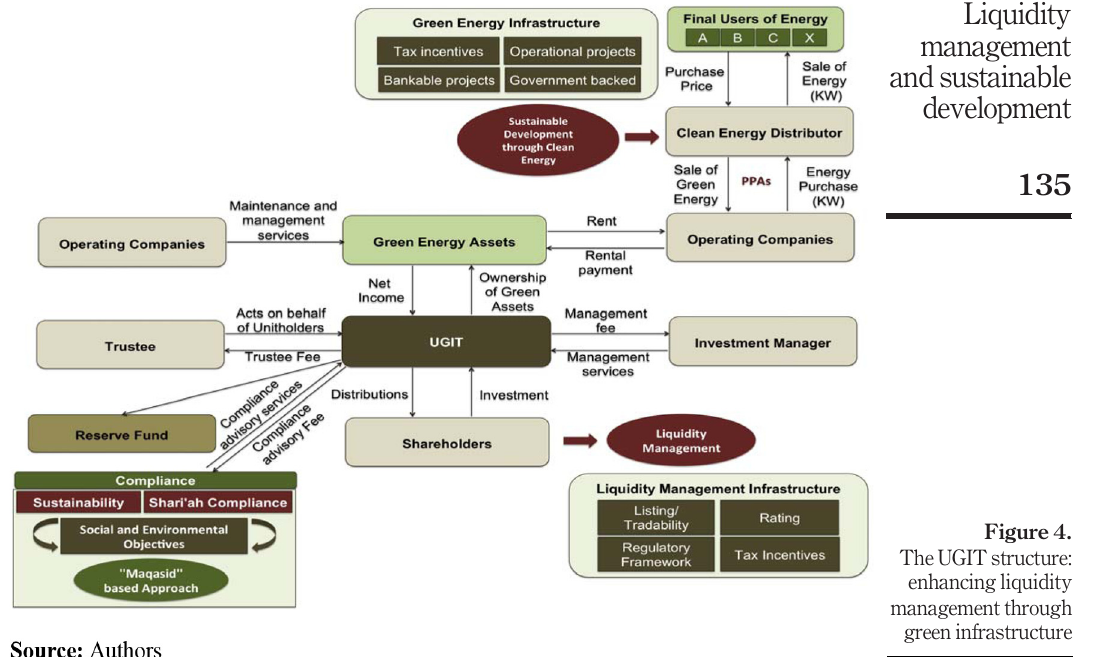
Figure 4. The UGIT structure: enhancing liquidity management through green